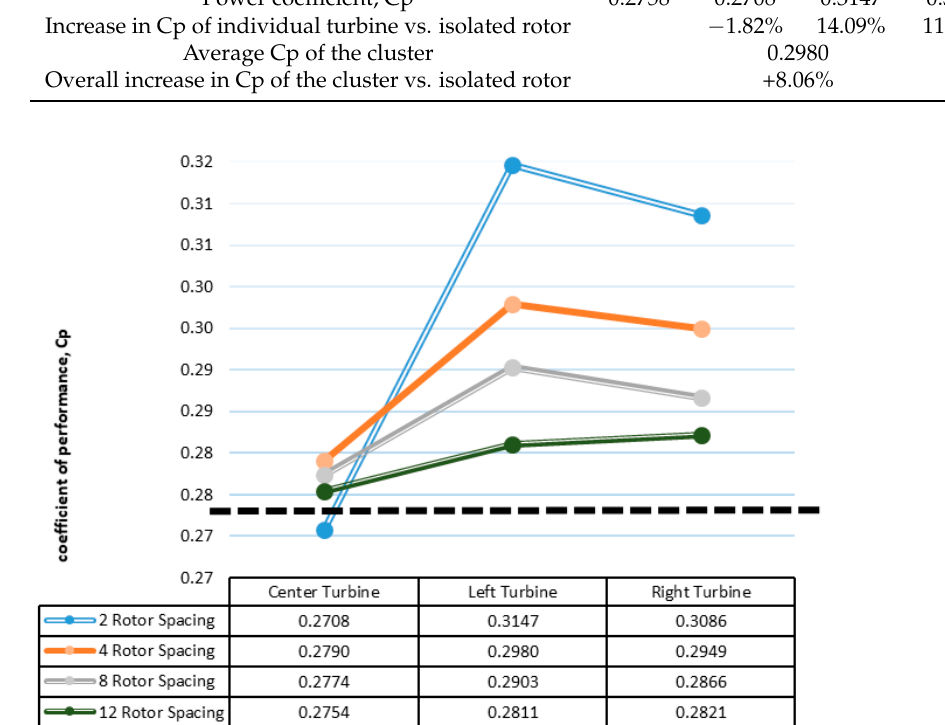
Figure 12. Summary of computed Cp at different turbine spacing distances. Note: black dashed line represents the Cp of the single turbine.